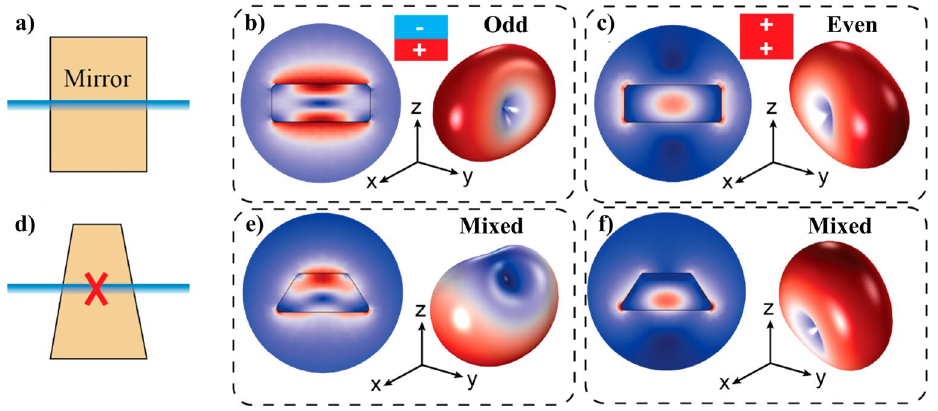
Figure 2. Lowest order resonant QNMs of a Si nanocylinder and a truncated Si nanocone. We consider only the QNMs that can be excited by a normally incident, x-polarized plane wave. Parameters of the nanocylinder: height 100 nm, radius 130 nm. Parameters of the nanocone: height 100 nm, bottom radius 130 nm, upper radius 65 nm. The refractive index of both nanoresonators is set to 4. ( a ) Scheme depicting the x–z cross-section of a cylinder, and it’s up-down mirror symmetry. ( b ) Lowest order QNM of the nanocylinder with odd parity. It can be easily identified as the well-known MD mode. Left: near field distribution in the x–z plane, right: radiation pattern. ( c ) Lowest order QNM with even parity, corresponding to the ED mode. Left and right pictures as in ( b ). ( d ) Representation of the x–z cross-section of a nanocone, indicating the lack of up-down mirror symmetry. As a result, the QNMs are no longer even or odd. In particular, the lowest order QNMs radiate as a combination of ED and MD multipoles. ( e – f ) Lowest order resonant QNMs of the nanocone. Left and right pictures display the same as in ( b ) and ( c ). As a result of the mixed electric and magnetic contributions, the forward and backward directivities of a single QNM can be boosted with respect to the